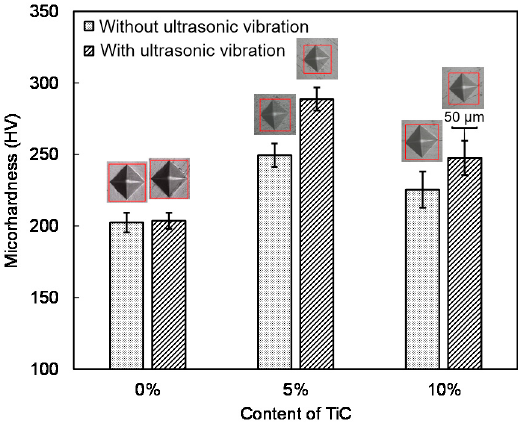
Figure 8. The effects of ultrasonic vibration and TiC content on microhardness.